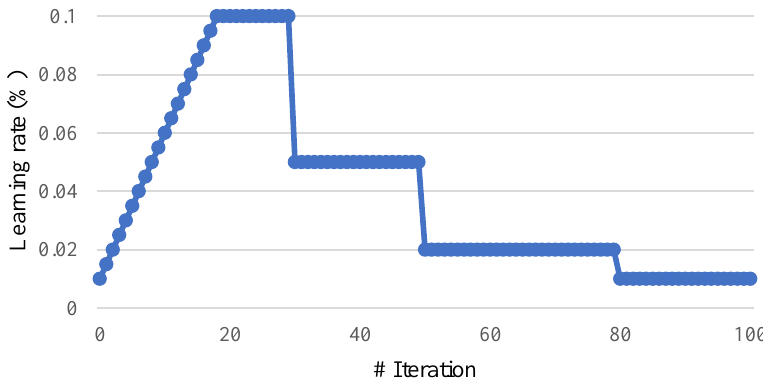
Figure 5. Learning rate changes in warm-up.